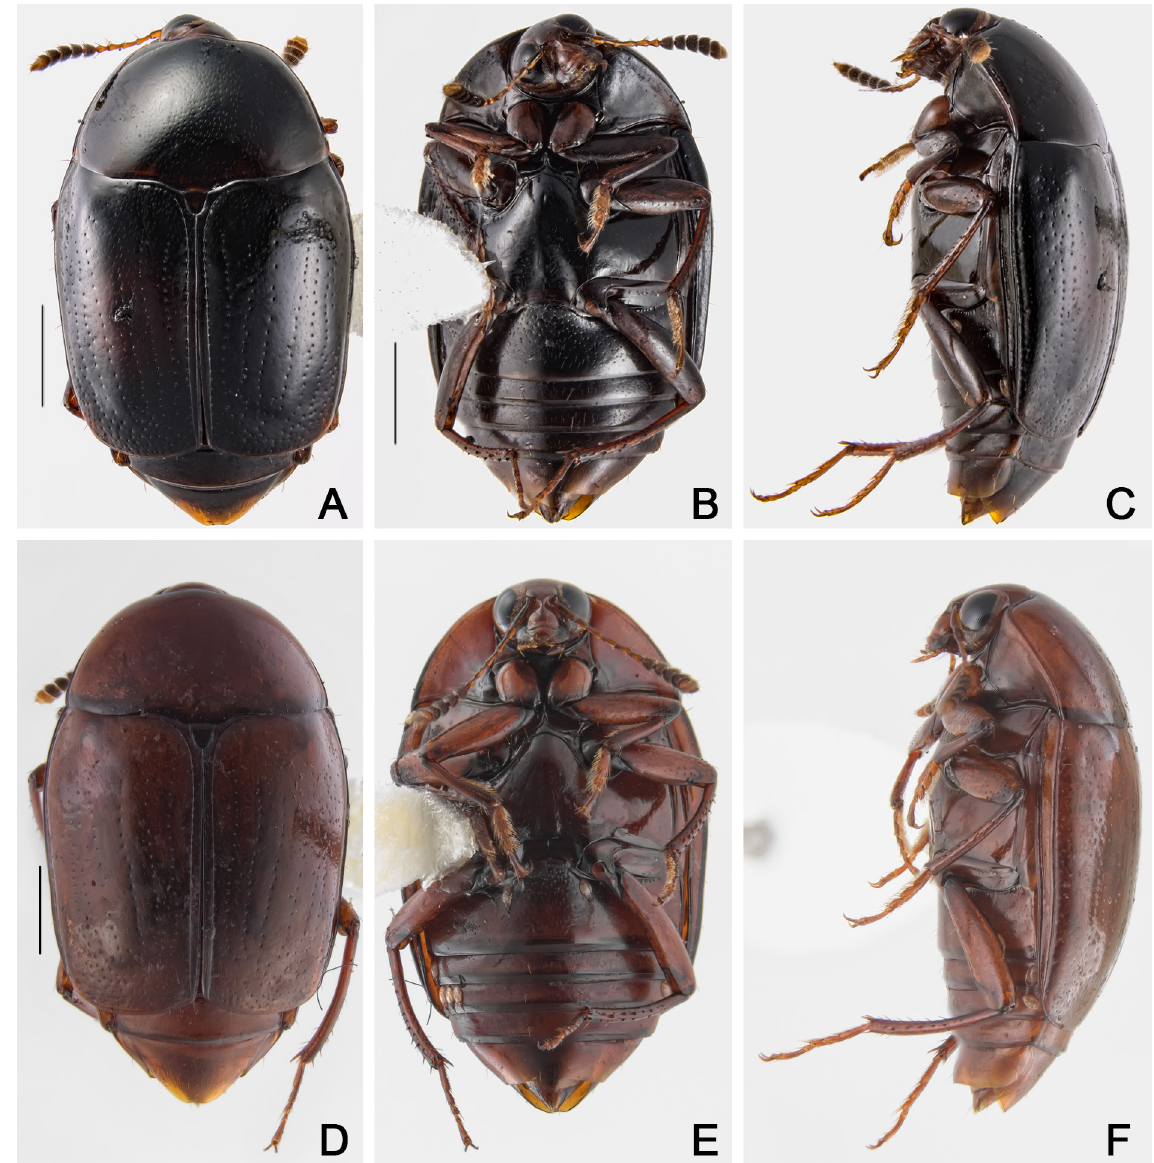
Fig. 56. Cyparium oberthueri Pic, 1956. A–C . Male specimen (CELC). A . Dorsal view. B . Ventral view. C . Lateral view. D–F . Different male specimen (CELC). D . Dorsal view. E . Ventral view. F . Lateral view. Specimens collected at Mata da Biologia (A–C) and Mata do Paraíso (D–F). Scale bars = 1.0